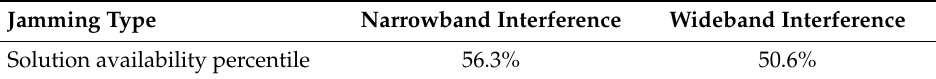
Table 4. Solution availability during GPS-only constellation